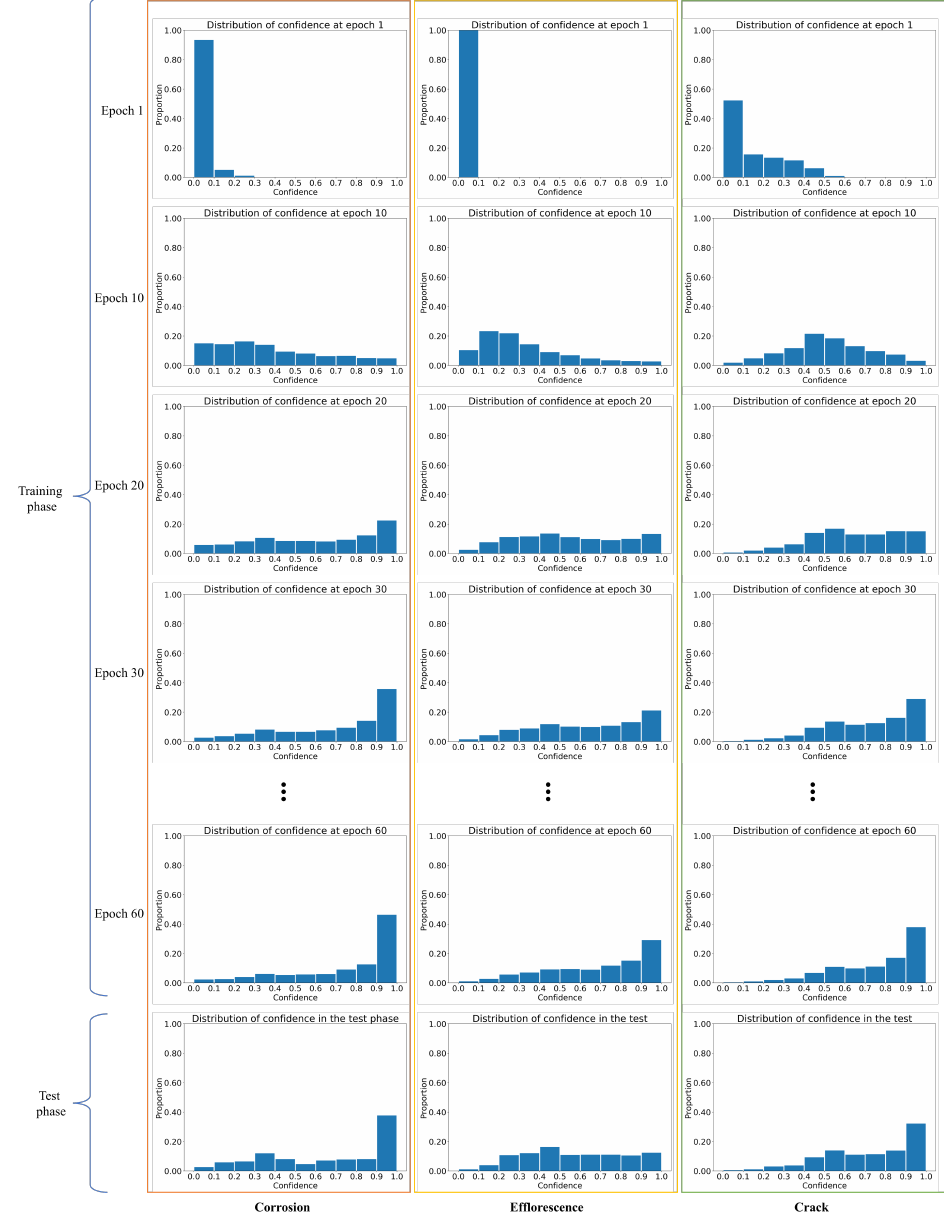
Figure 7. Distributions of the confidence in epochs 1, 10, 20, 30, and 60 of the training and test